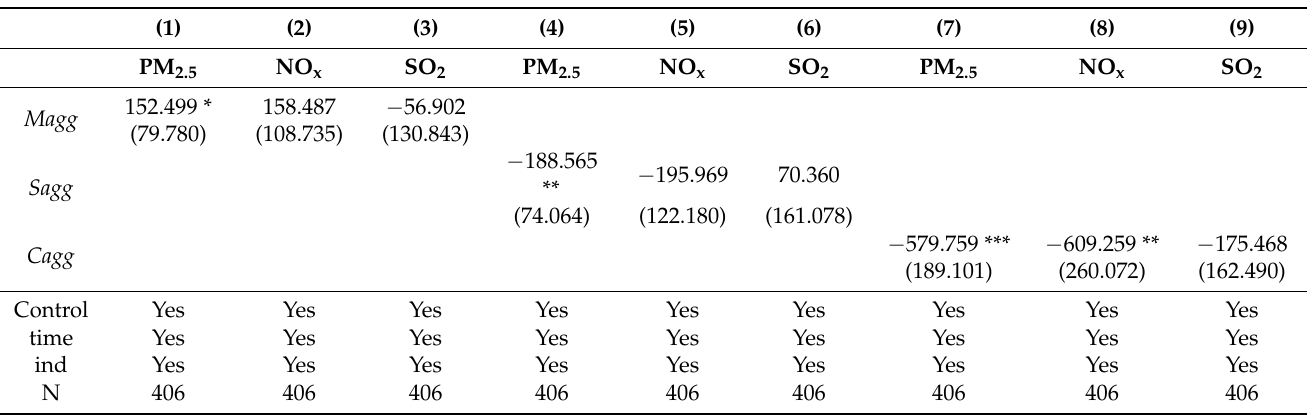
Table 11. Instrumental variable test of the effect of industrial agglomeration on air